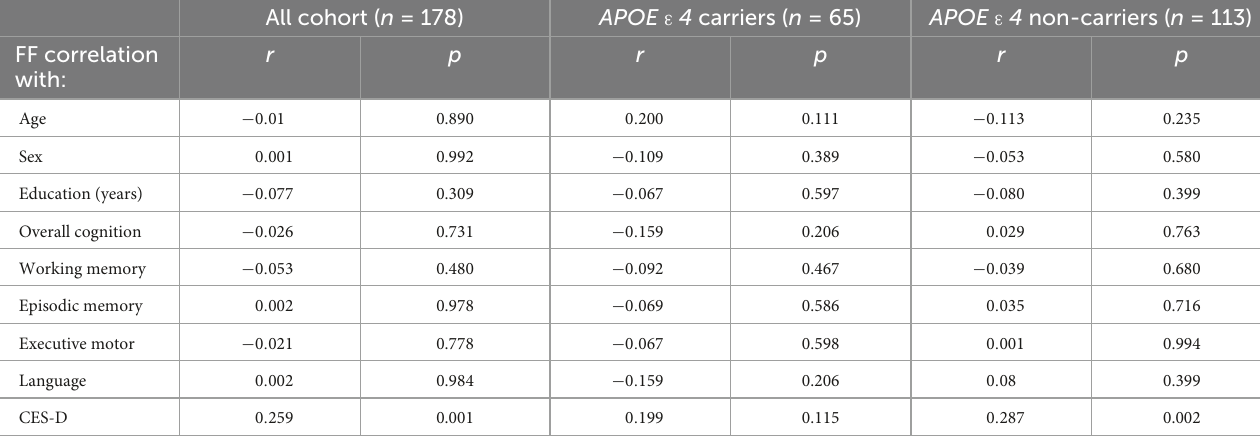
TABLE 2 Association between SCD (MFQ_FF) and objective cognitive performance and demographic characteristics. All cohort ( n = 178) APOE ε 4 carriers ( n = 65) APOE ε 4 non-carriers ( n = 113)